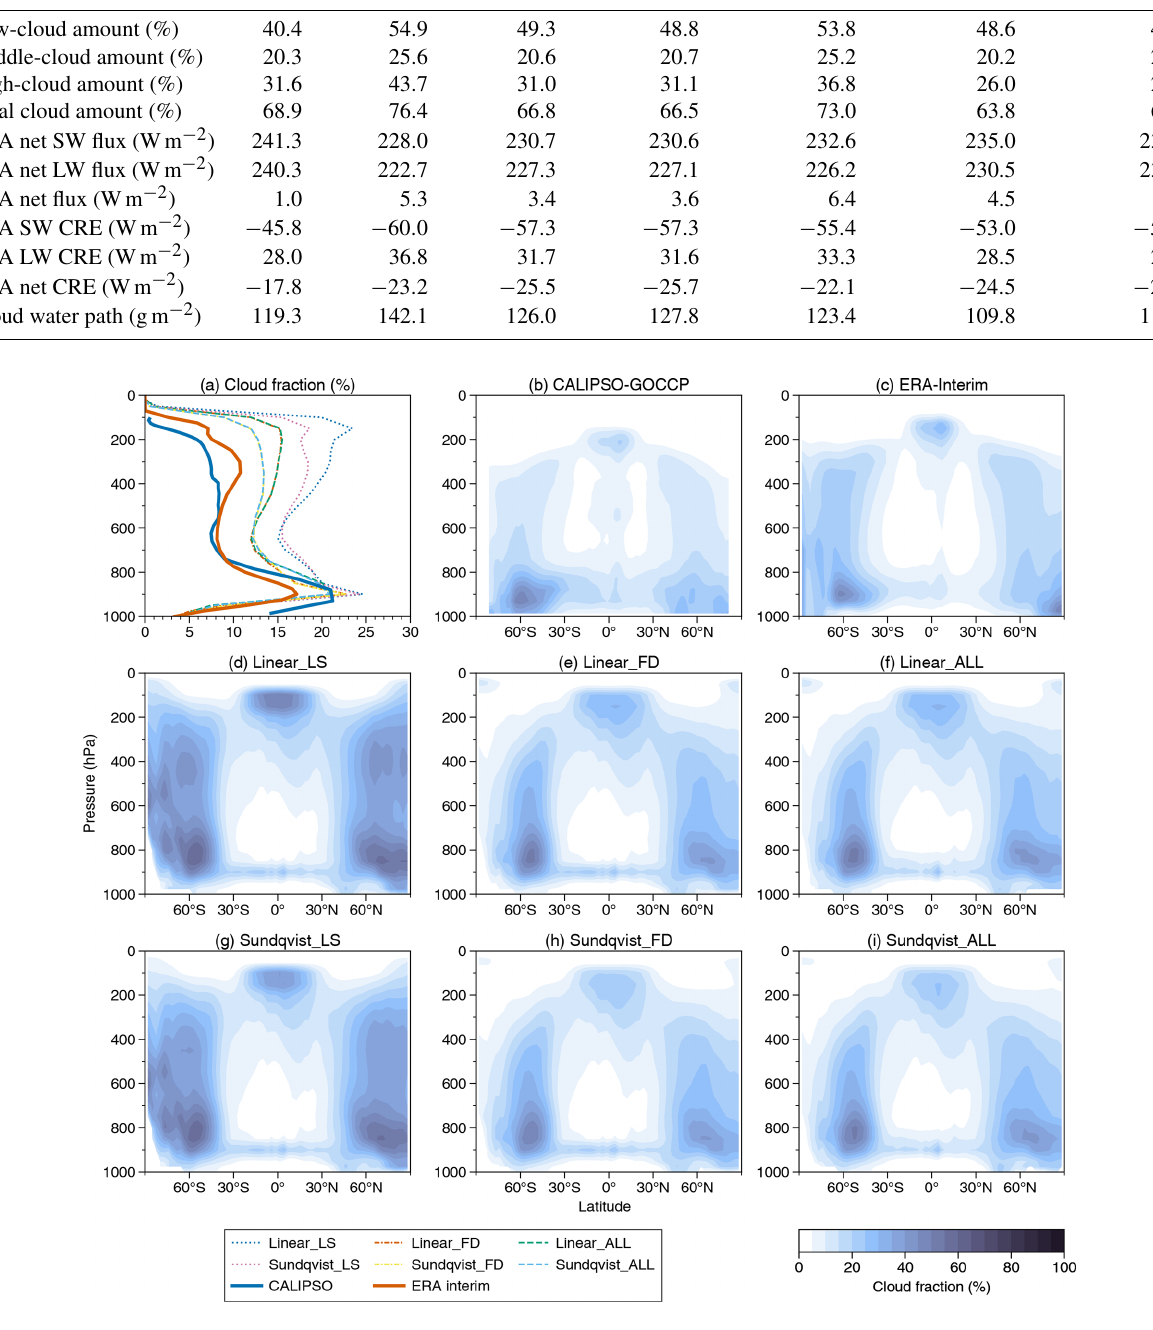
Figure 6. (a) The annual and global mean of cloud fraction profiles from the CALIPSO-GOCCP (thick solid blue line), ERA-Interim reanal- ysis (thick solid orange line) and different Isca simulations, including linear_LS (dotted blue), linear_FD (dash-dotted orange), linear_ALL (dashed green), Sundqvist_LS (dotted pink), Sundqvist_FD (dash-dotted yellow) and Sundqvist_ALL (dashed azure). (b–i) The same as in (a) but for annual and zonal mean of cloud fraction